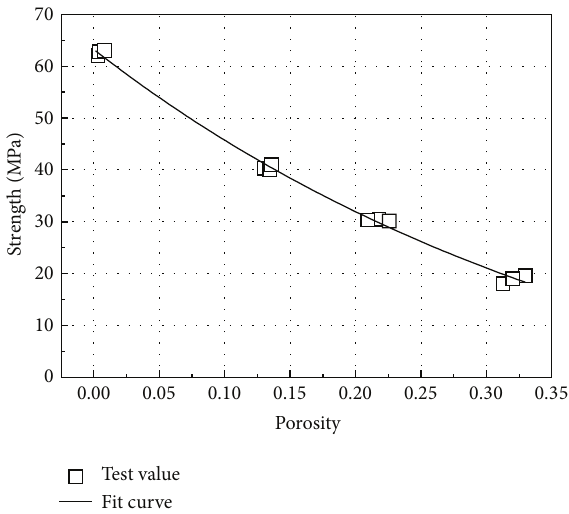
Figure 6: The variation of compressive strength of EPS particles replacing coarse aggregate with